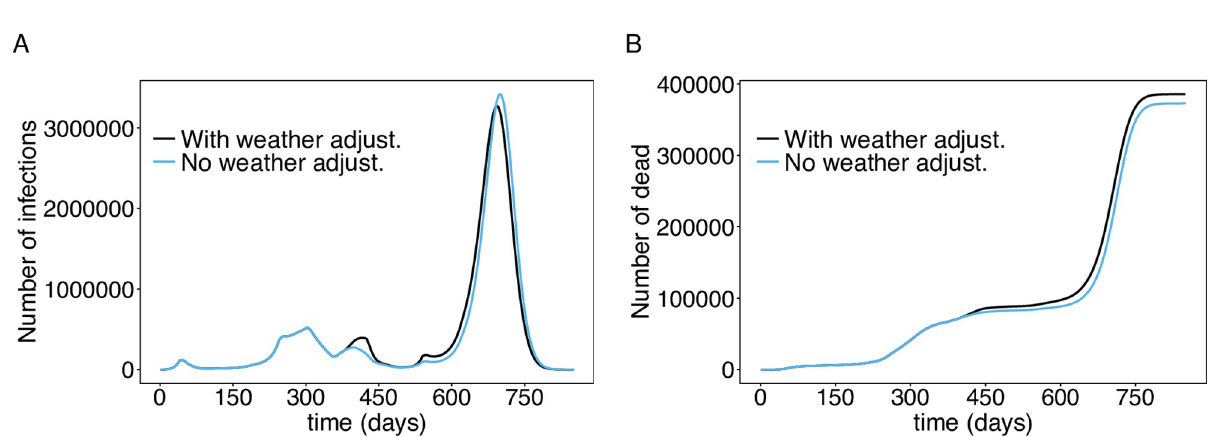
Fig 8. Effect of weather adjustments. (A) Shown are the total numbers of infected individuals assuming a continuation of the current contact reductions (scenario i), with and without the weather adjustments in 2021. (B) Shown are the corresponding deaths. The parameters used for the simulations are listed in S1 to S11